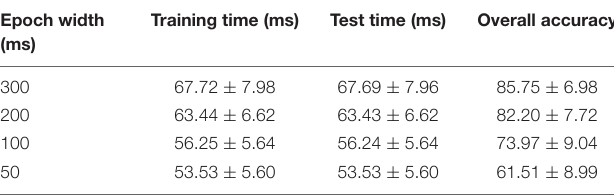
TABLE 3 | The performance of the online classification system on different epoch widths over the entire movements and intact subjects as well as its average running time on the training and test